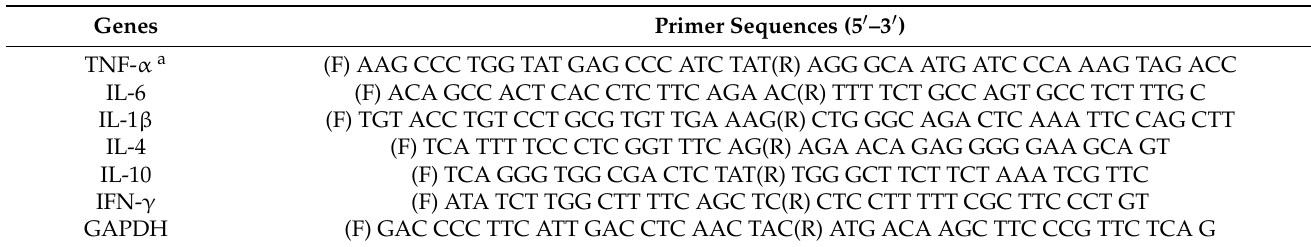
Table 1. Primers used for real-time PCR. Primer Sequences (5 (cid:48) –3 (cid:48)